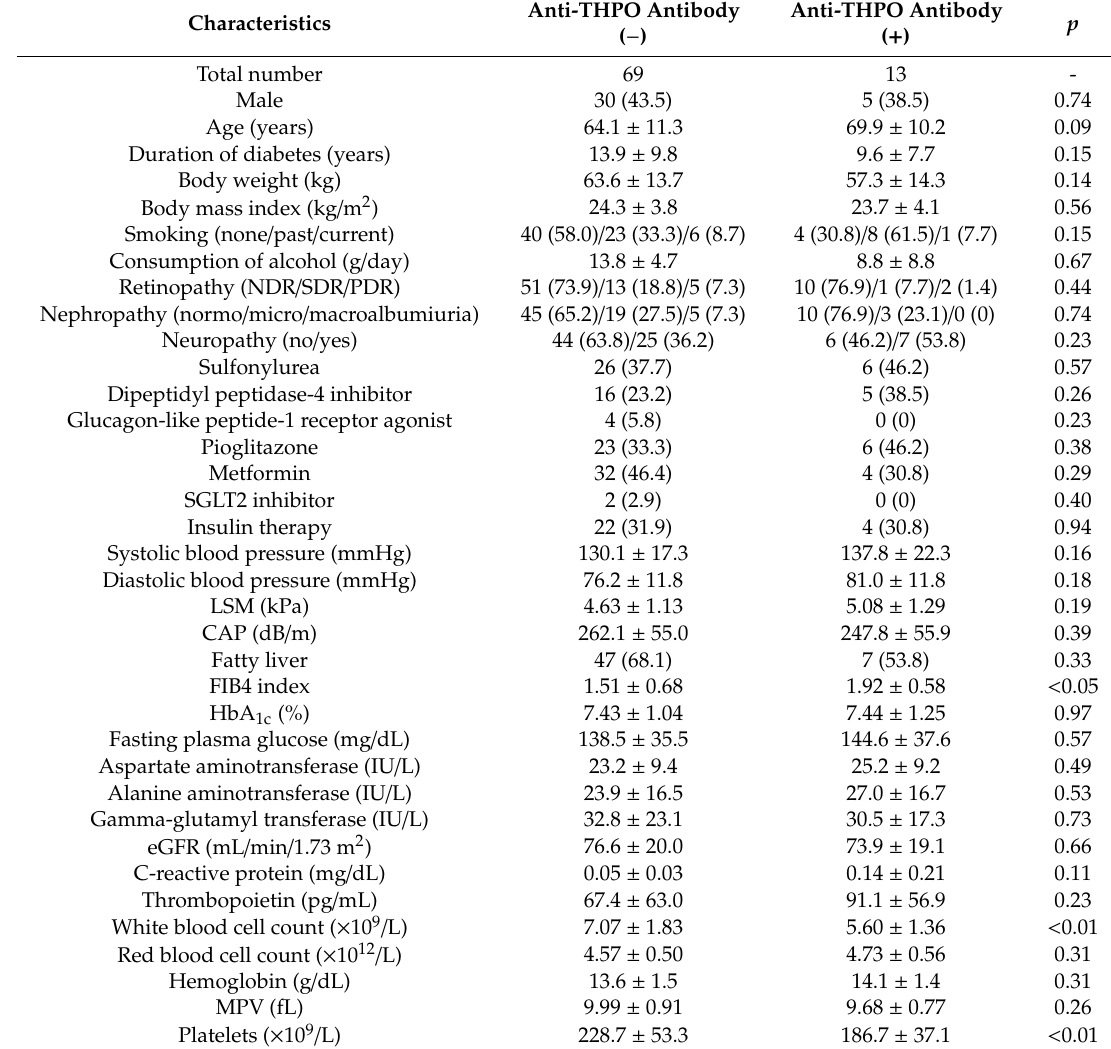
Table 1. Clinical and laboratory characteristics of the patients ( n =